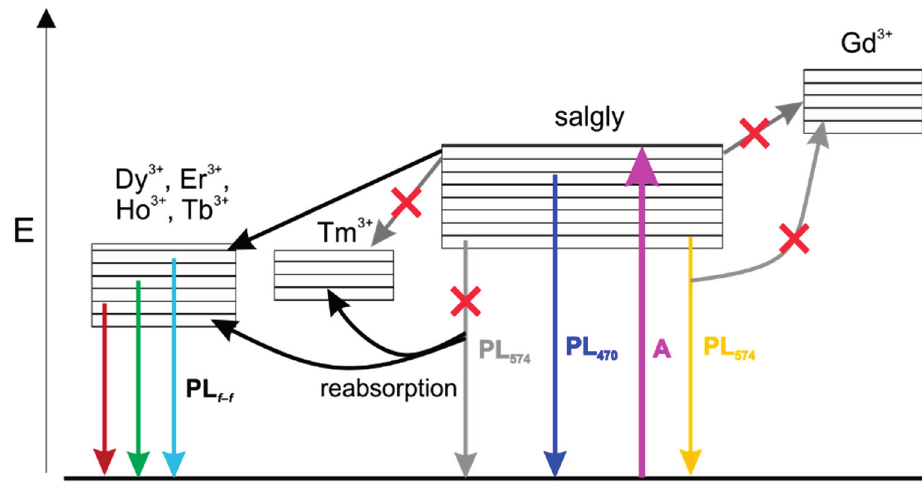
Figure 7. Schematic representation of the energy transfer processes taking place in the studied lanthanide complexes (powders): Energy absorption (A), emission (PL) and intersystem crossings. Red croses mean improbable processes.